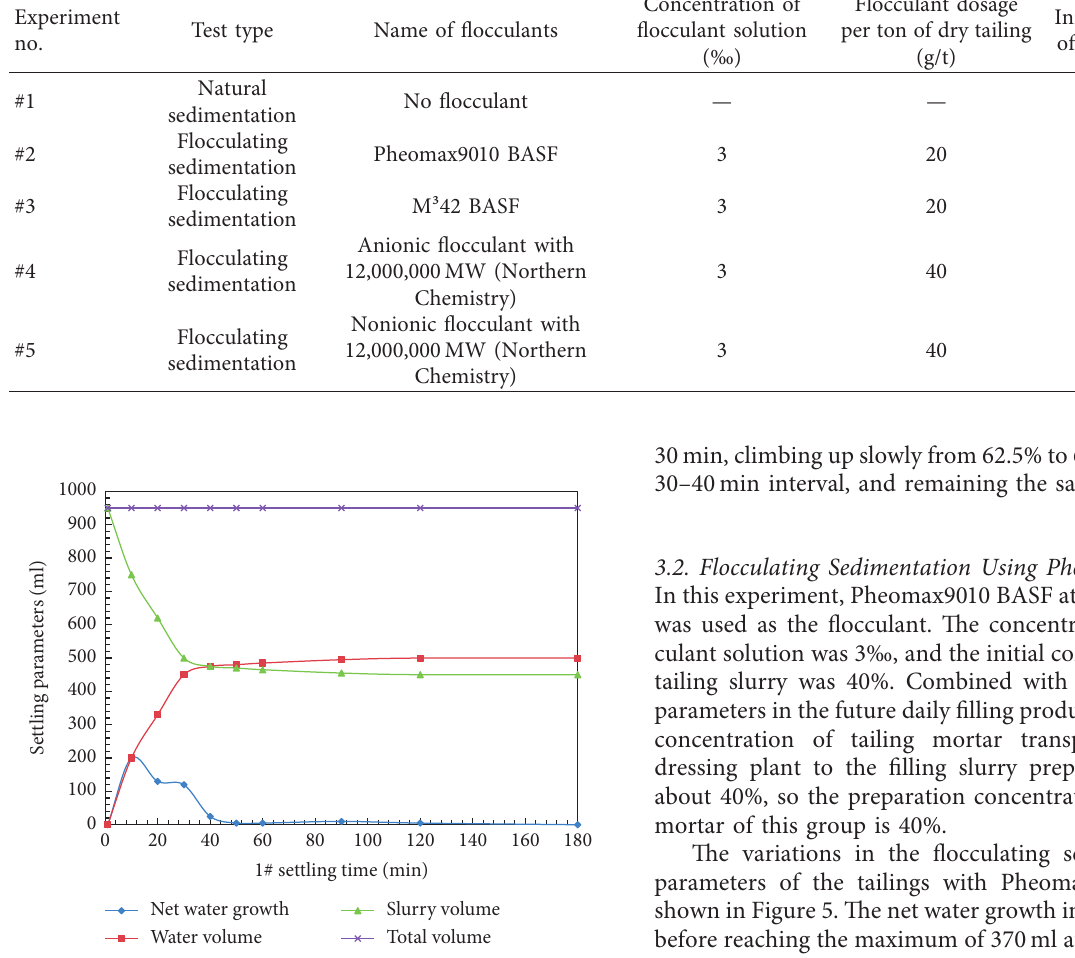
Figure 3: Natural sedimentation test parameters of tailings (#1).